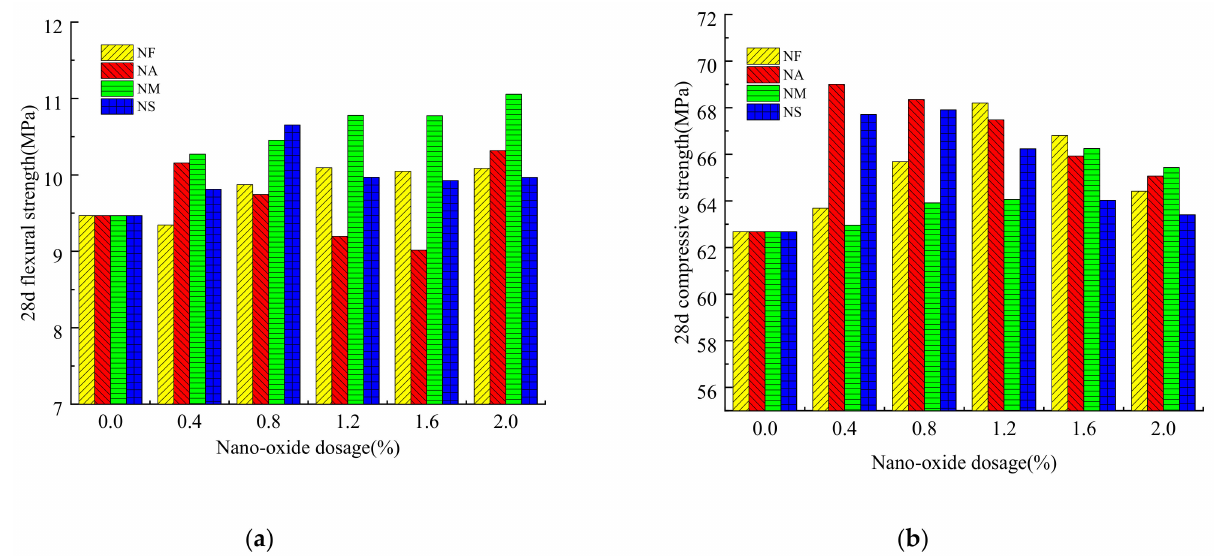
Figure 3. Effect of nano-oxides on 28d strength of grouting material. ( a ) 28d flexural strength; ( b ) 28d compressive strength. The meanings of NF, NA, NM, and NS are Nano-Fe 2 O 3 , Nano-Al 2 O 3 , Nano-MgO, and Nano-SiO 2 ,